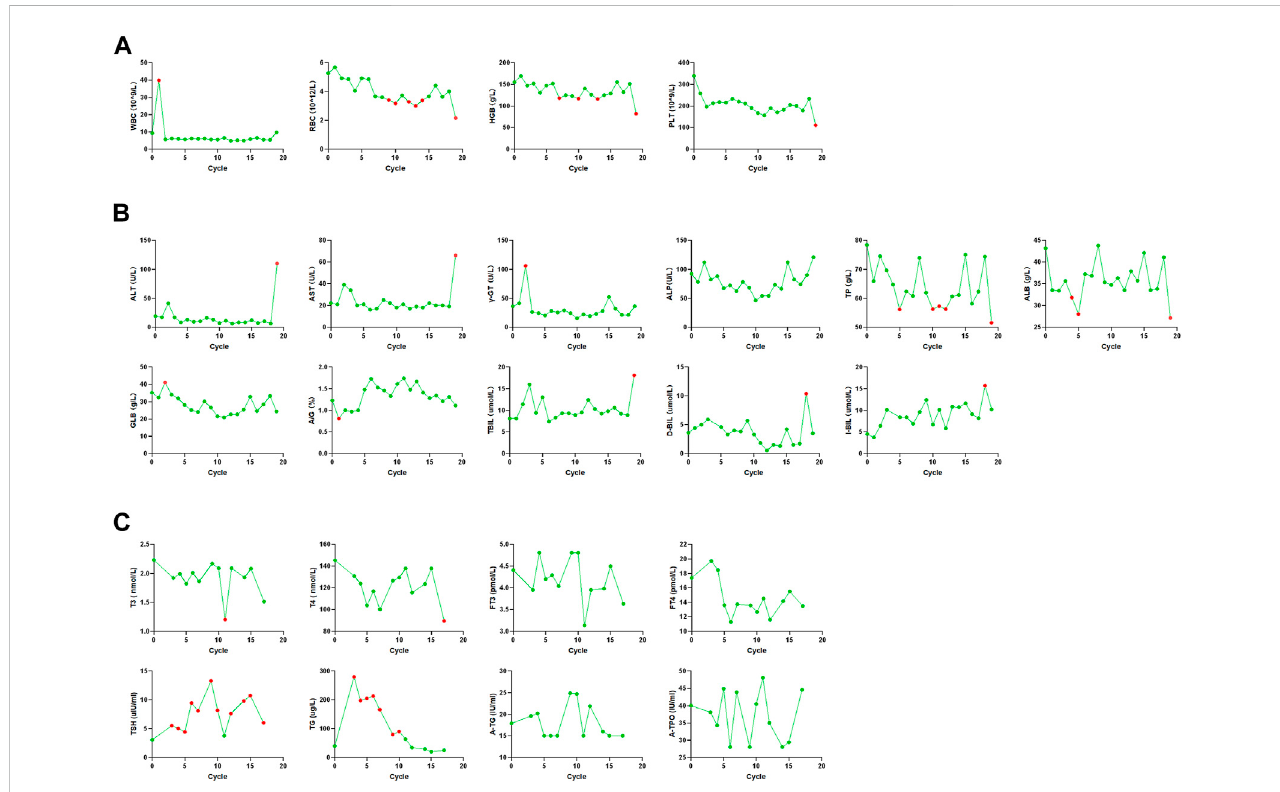
FIGURE 3 Changes in blood cell counts, liver function, and thyroid function. (A) Blood cell counts was almost within normal limits until the end of treatment. (B) Liver function was almost within normal limits until the end of treatment. (C) Thyroid function was almost within normal limits until the end of treatment.